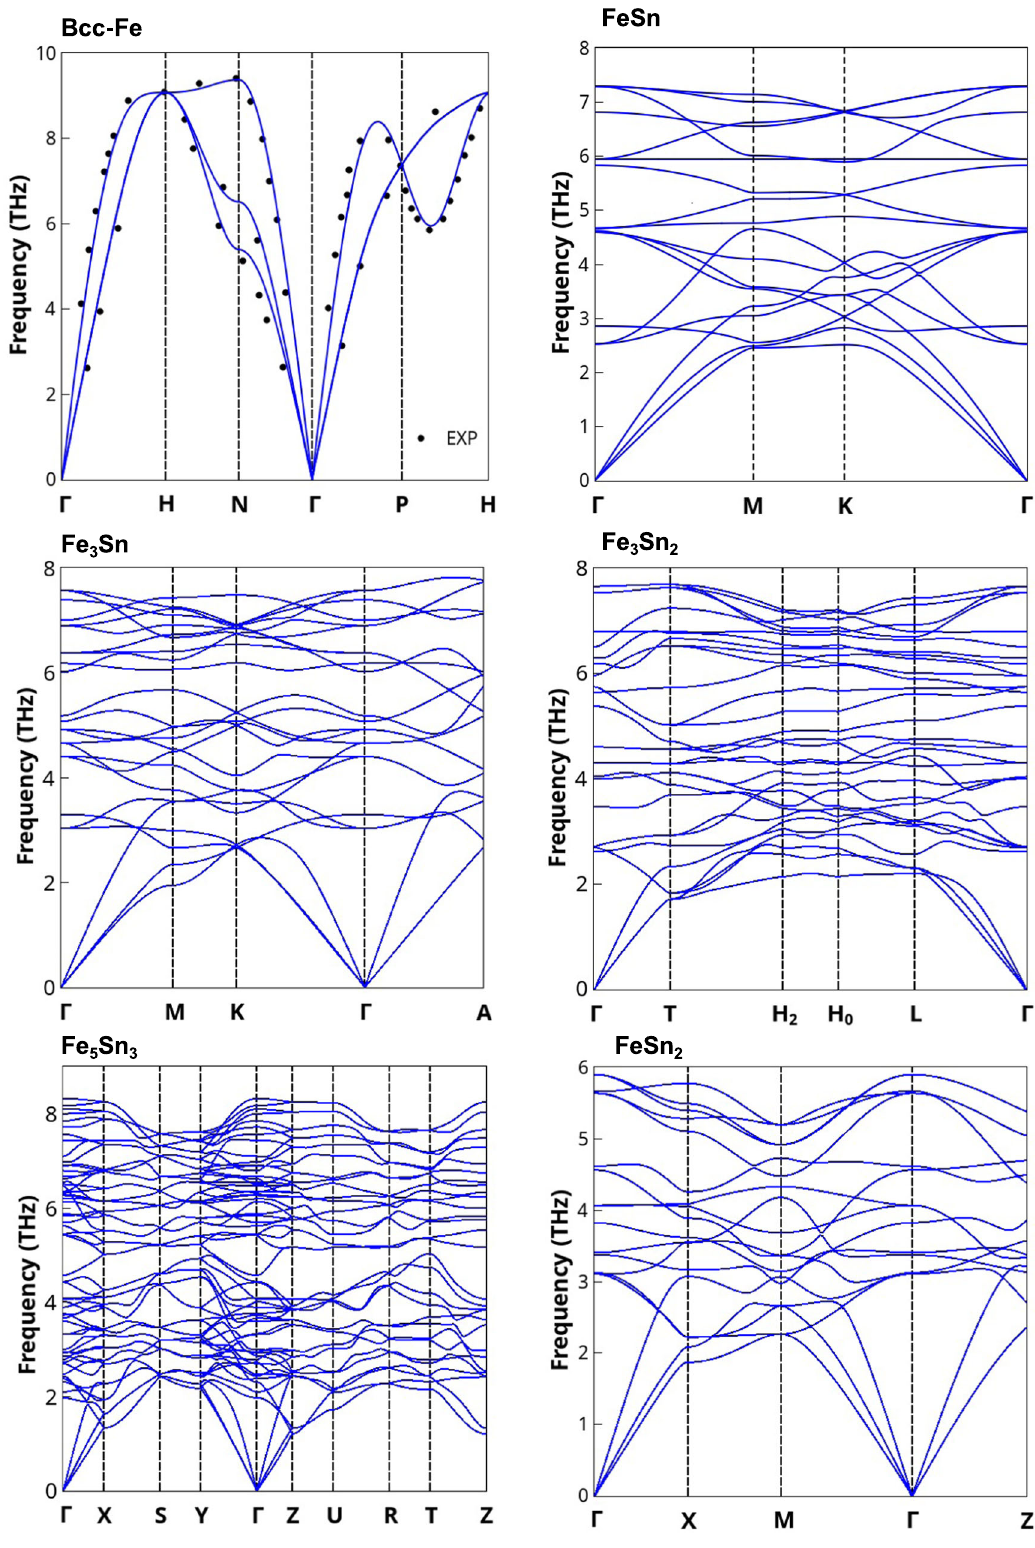
Fig. 1 Phonon dispersions of the pure elements and intermetallic phases in the Fe – Sn system. The black solid points represent the experimental data from ref. 37